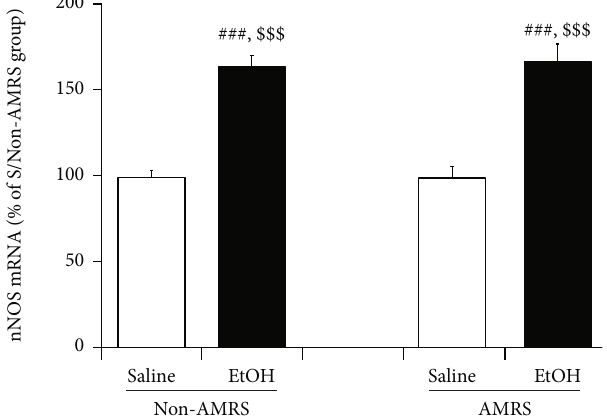
Figure 6: Solitary nNOS mRNA expressions during EtOHW. Data are expressed as mean ± SEM ( n = 6 ) of the percentage of saline/ non-AMRS group. ### p < 0 : 001 versus saline/non-AMRS group; $$$ p < 0 : 001 versus saline/AMRS